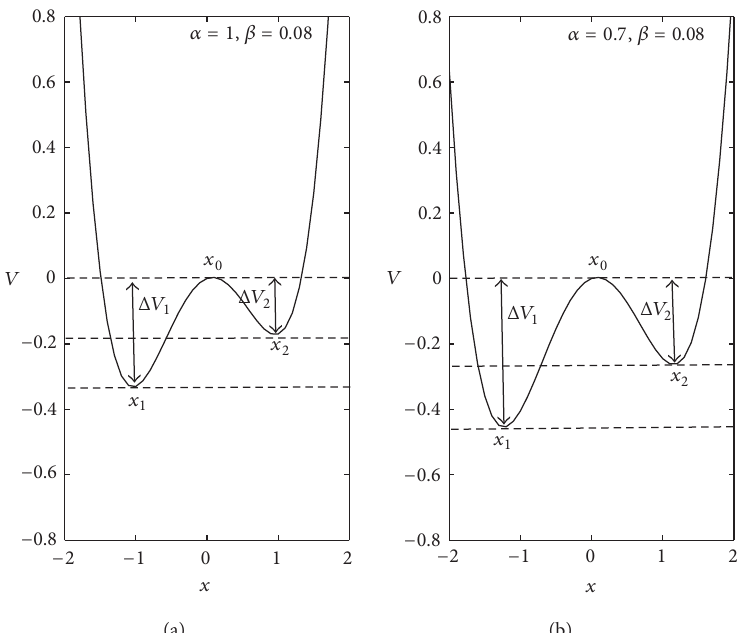
Figure 6: Asymmetric potential 𝑉 as a function of the state variable 𝑥 . The asymmetry in the depth of the wells is obtained setting 𝛽 ̸= 0 in (3). Here the effect of 𝛽 (𝛽 = 0.08) on the shape of the potential 𝑉 is illustrated for the same values of the control parameter 𝛼 used in Figure 5: (a) 𝛼 = 1 and (b) 𝛼 = 0.7. Δ𝑉 1 and Δ𝑉 2 are the barriers between 𝑥 1 ( 𝑥 2 ) and 𝑥 0 , respectively. Dashed lines denote the upper and lower bounds of the potential barriers. Table 1: Disease characteristics and parameters of the mechanistic stochastic model. The table summarizes analogies and links between MS characteristics (left column) and model parameters in (4), in the right column. Disease characteristics during the relapsing-remitting phase Mechanistic, stochastic